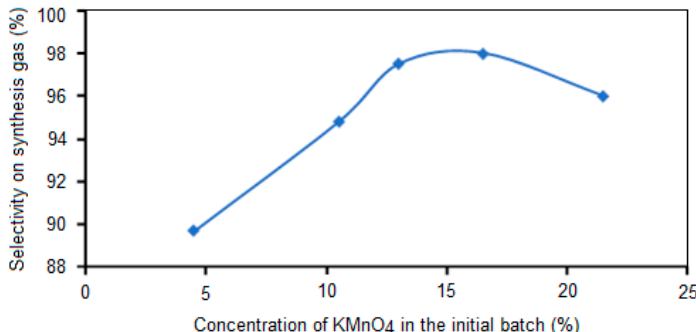
Figure 9. Selectivity of catalysts as a function of the concentration of KMnO 4 in the initial batch.